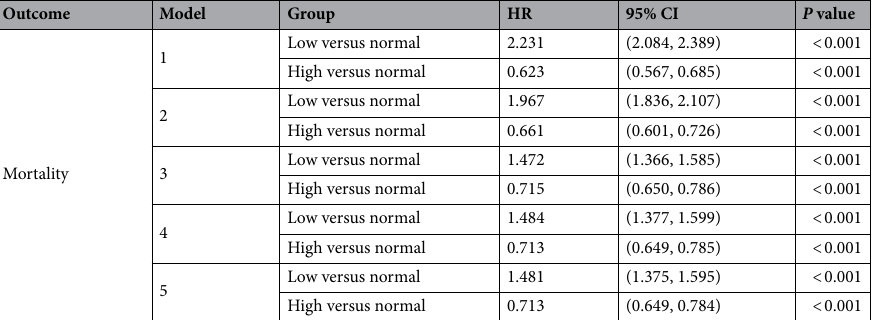
Table 3. Cox regression analysis for the risk of mortality according to the TCO 2 category groups. Model 1: TCO 2 only. Model 2: Model 1 + sex, age, history of hypertension and diabetes. Model 3: Model 2 + baseline kidney function as MDRD-GFR. Model 4: Model 3 + usage of sodium bicarbonate. Model 5: Model 4 + RAAS blockades + Diuretics group. Group definition: Low group, < 22 mEq/L versus Normal group, 22–29 mEq/L versus High group, ≥ 30 mEq/L. CI confidence interval, ESRD end-stage renal disease, GFR glomerular filtration rate, HR hazard ratio, MDRD modification of diet in renal disease, TCO 2 total CO 2